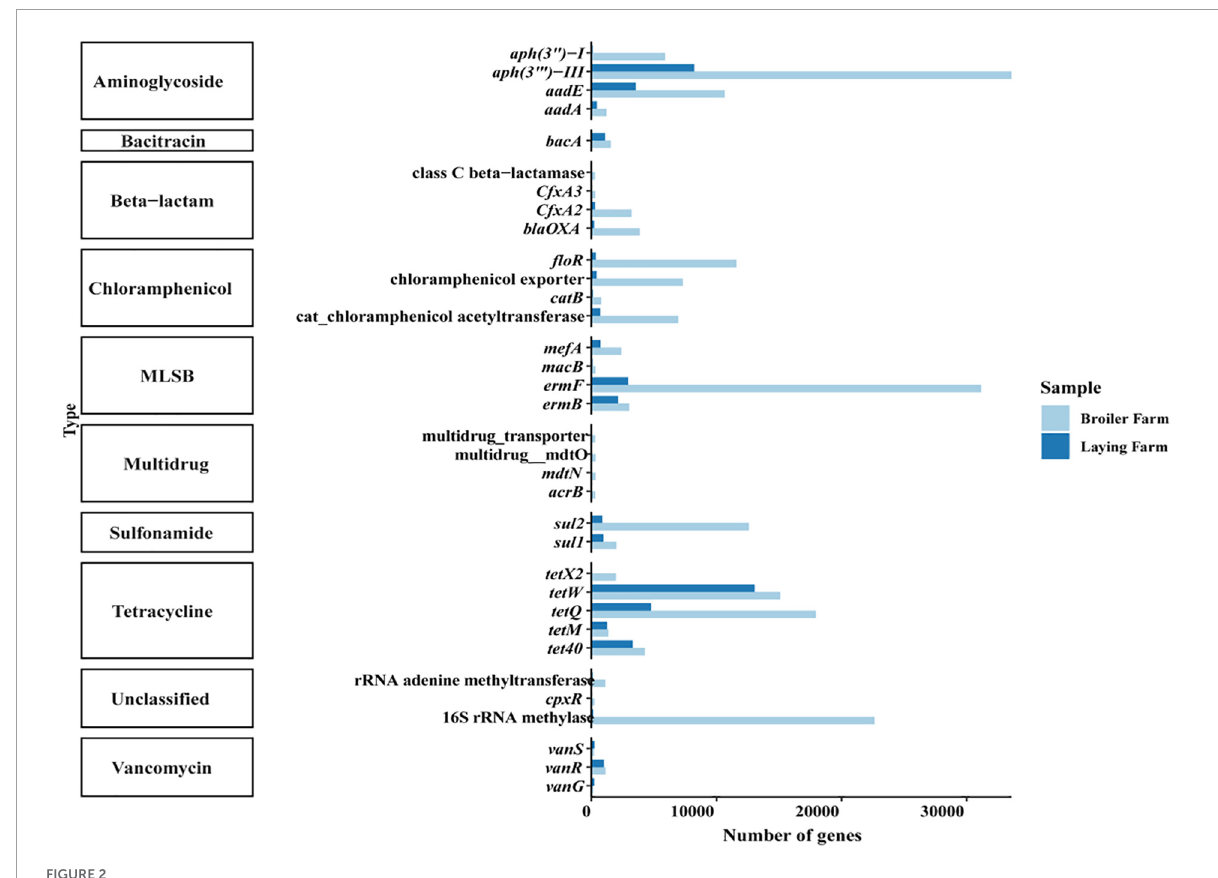
FIGURE2 The absolute abundance of top ten ARG classification and their subtypes.